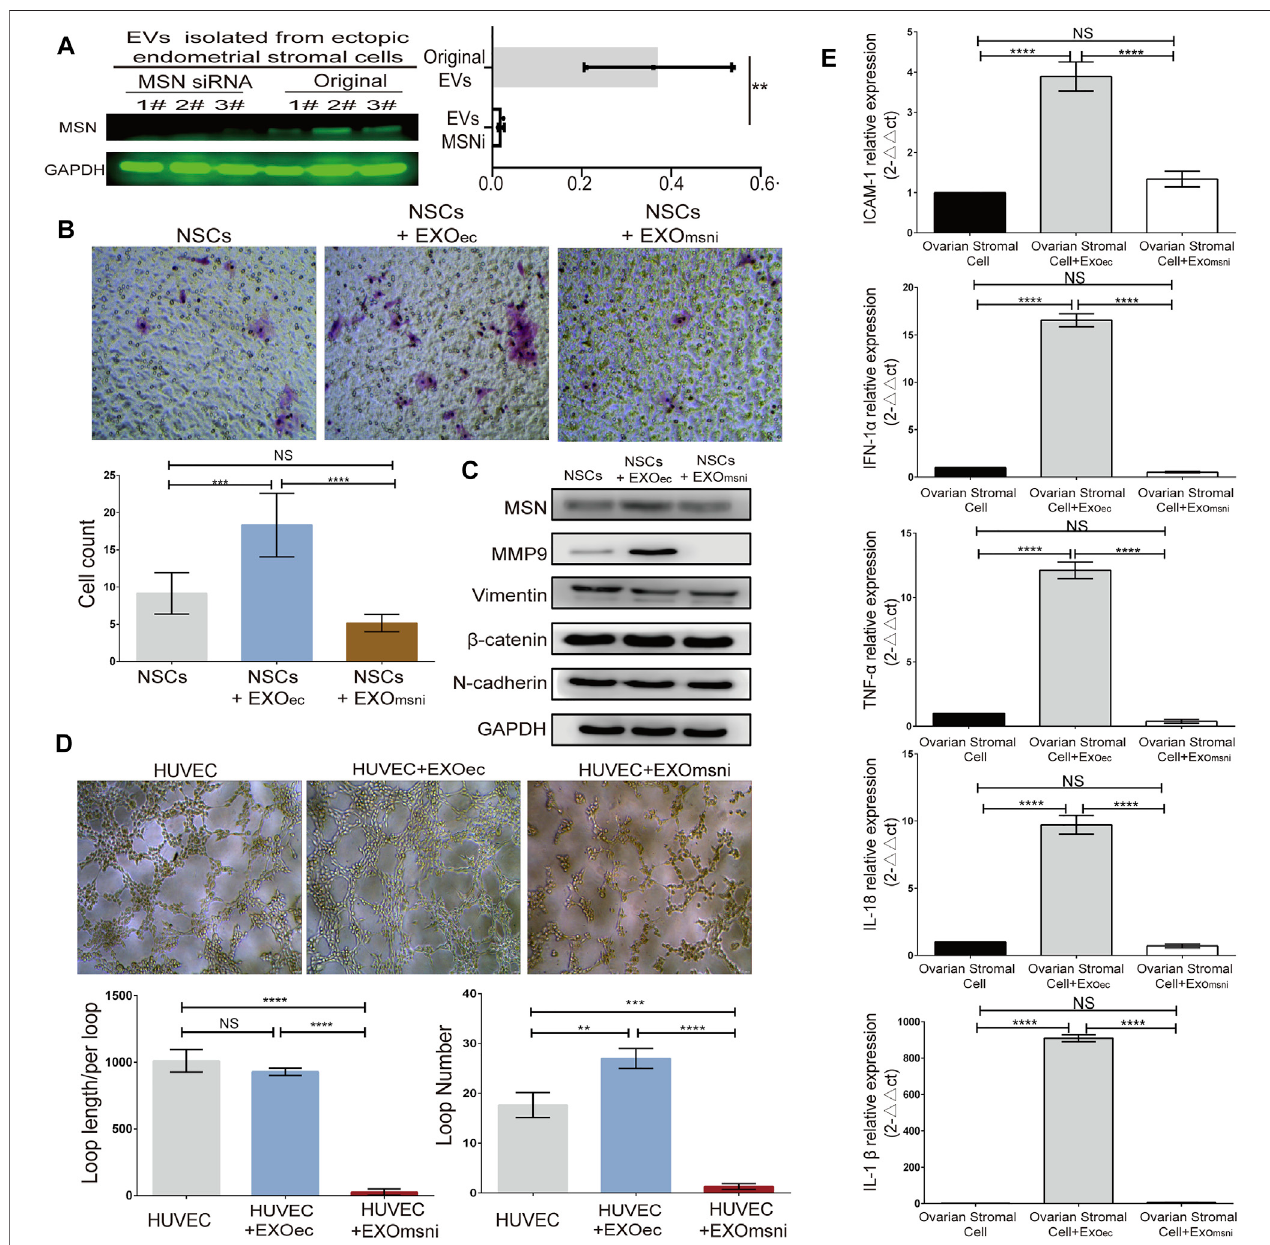
FIGURE4| ExosomalMoesininducedtheexpressionofMMP9,VEGFR2andin fl ammatoryfactors. (A) WesternblottingdetectionofMSNinexosomesfromESCs after siRNA transfection. (B) Transwell assay and quanti fi cation ofthemigrationofNSCs treatedwithexosome+MSNi. (C) Western blottingdetection oftheexpression ofMSN,MMP9,andEMT-relatedproteins. (D) Tubeformationafterexo+MSNiandectopicexosomestreatment. (E) RT-qPCRanalysisofin fl ammatorycytokines,data were expressed as mean ± SEM, NS, no signi fi cance, **** p < 0.0001. EXO, ectopic stromal cells derived exsomes. MSNi, MSN siRNA 。 .